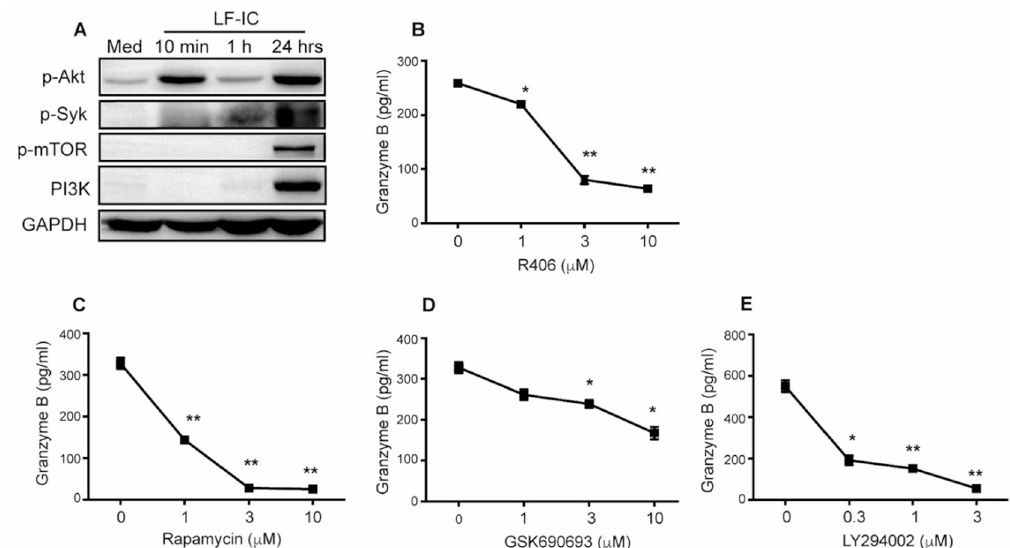
Figure 5. The signaling pathway for the tumoricidal activity empowerment to monocytes by LF-IC.